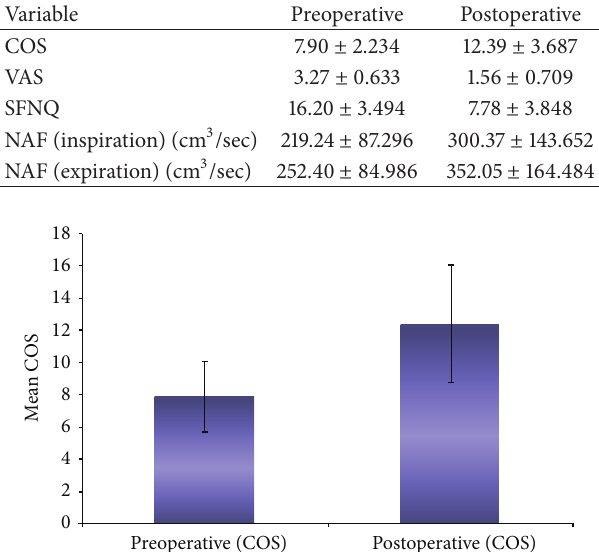
Figure 1: Preoperative and postoperative mean composite olfactory score